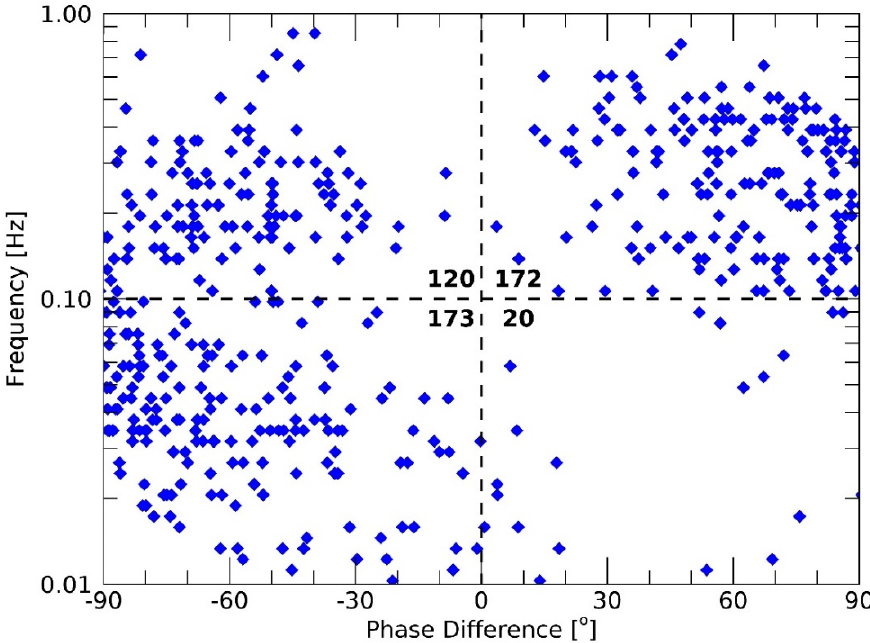
Figure 8. Distributions of the phase difference and frequency for the selected wavy intervals. The numbers at the center of the figure denote the number of intervals in each quadrant.